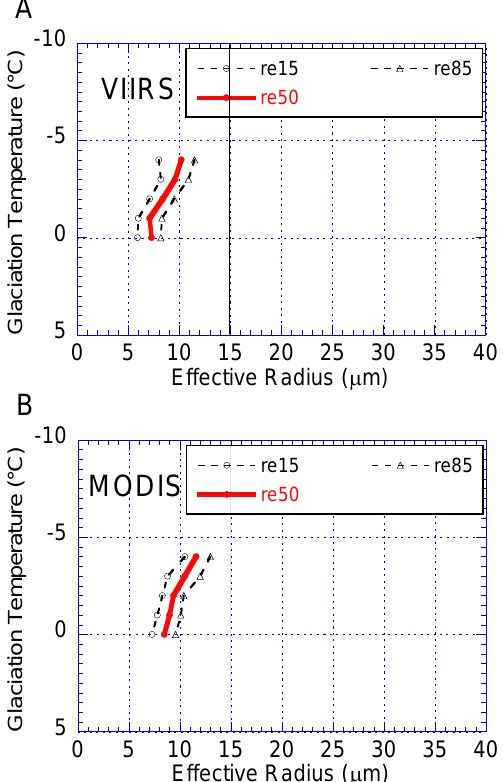
Fig. 12. Same as Fig. 5, but for the regionally polluted area over Buffalo, NY, USA, and to the south of Lake Ontario, on 5 June 2012. The T – r e lines are plotted for the rectangles shown in Fig. 10. The red line shows the median r e for any given T , and the broken lines show the 15th and 85th percentiles, as indication for the spread of r e for a given T